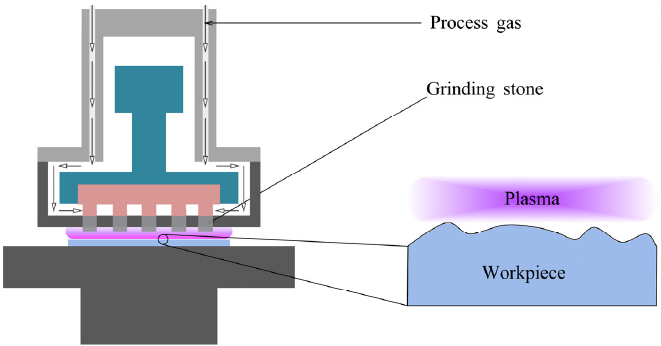
Figure 9. The schematic diagram of PAP [95].